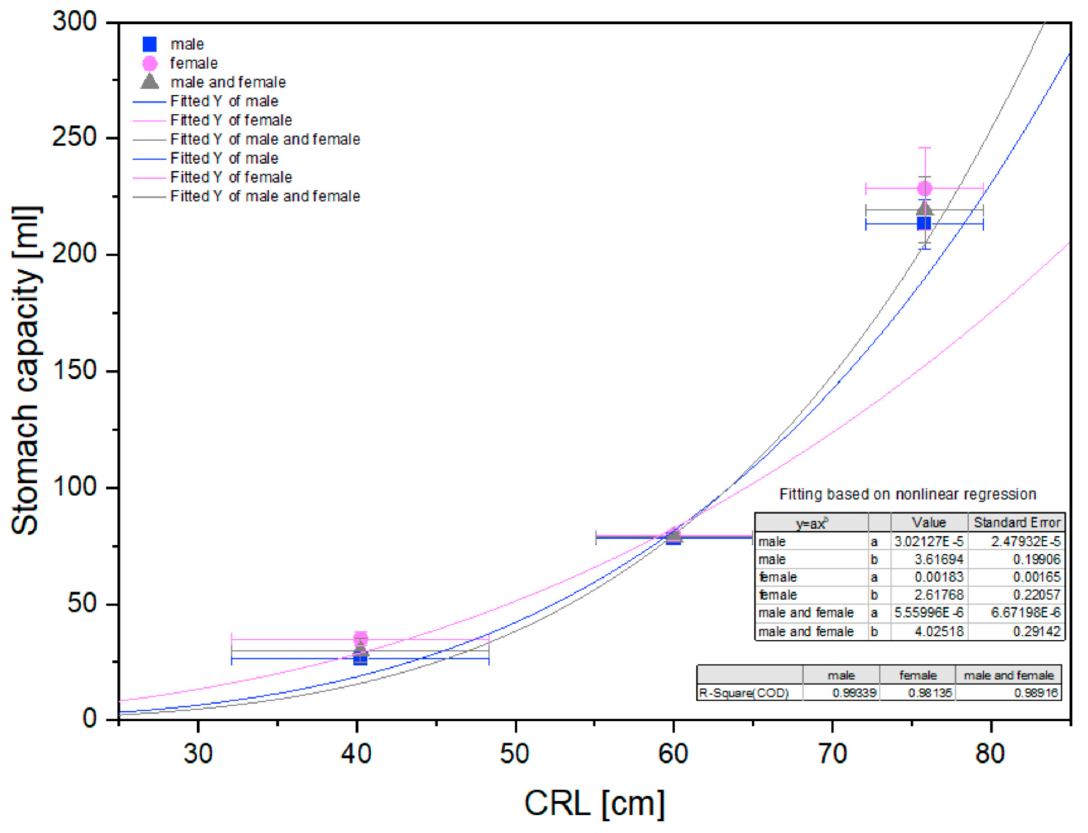
Figure 16. Stomach volume in subsequent age groups in relation to